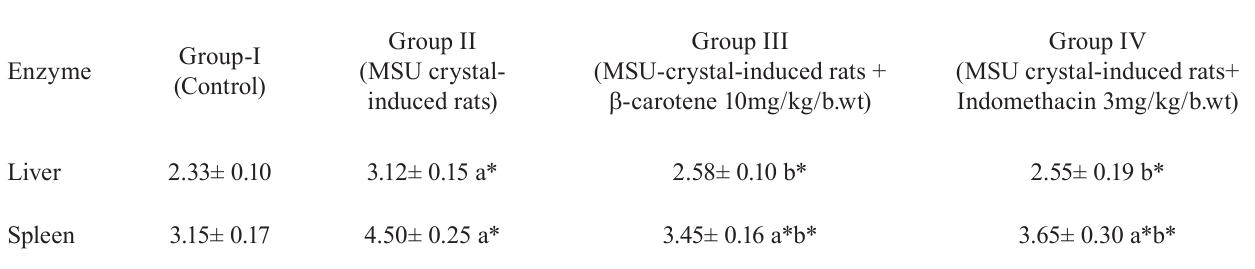
TABLE ll - Effect of β -carotene and Indomethacin on lipid peroxidation(mg/dl) of liver and spleen in MSU crystal -induced arthritis rats